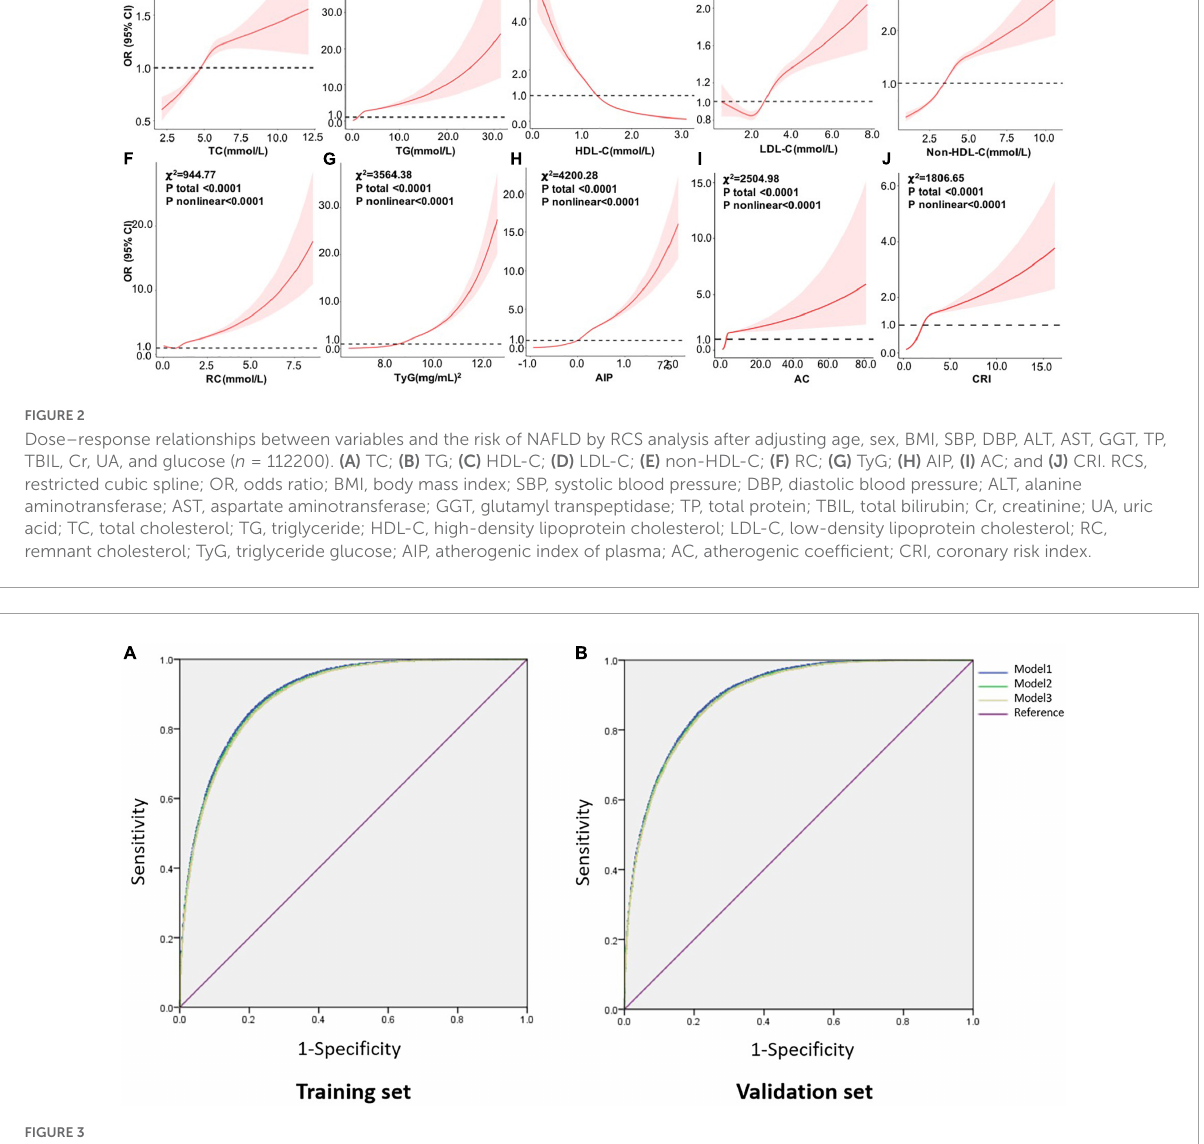
112,200 adult subjects, especially in women and lean